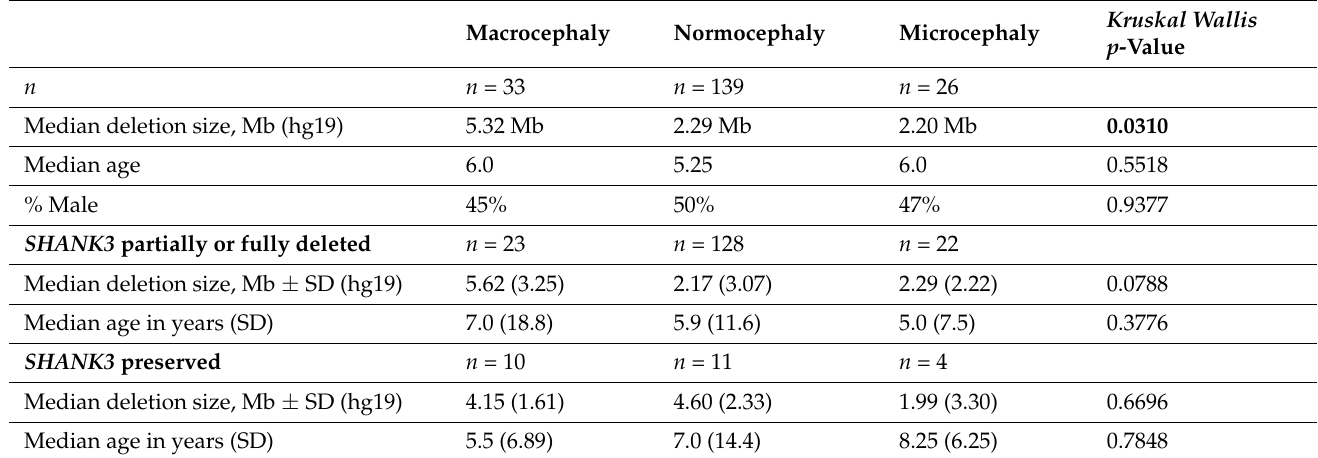
Table 3. Differences in 22q13 deletions and demographics by the size of the head.